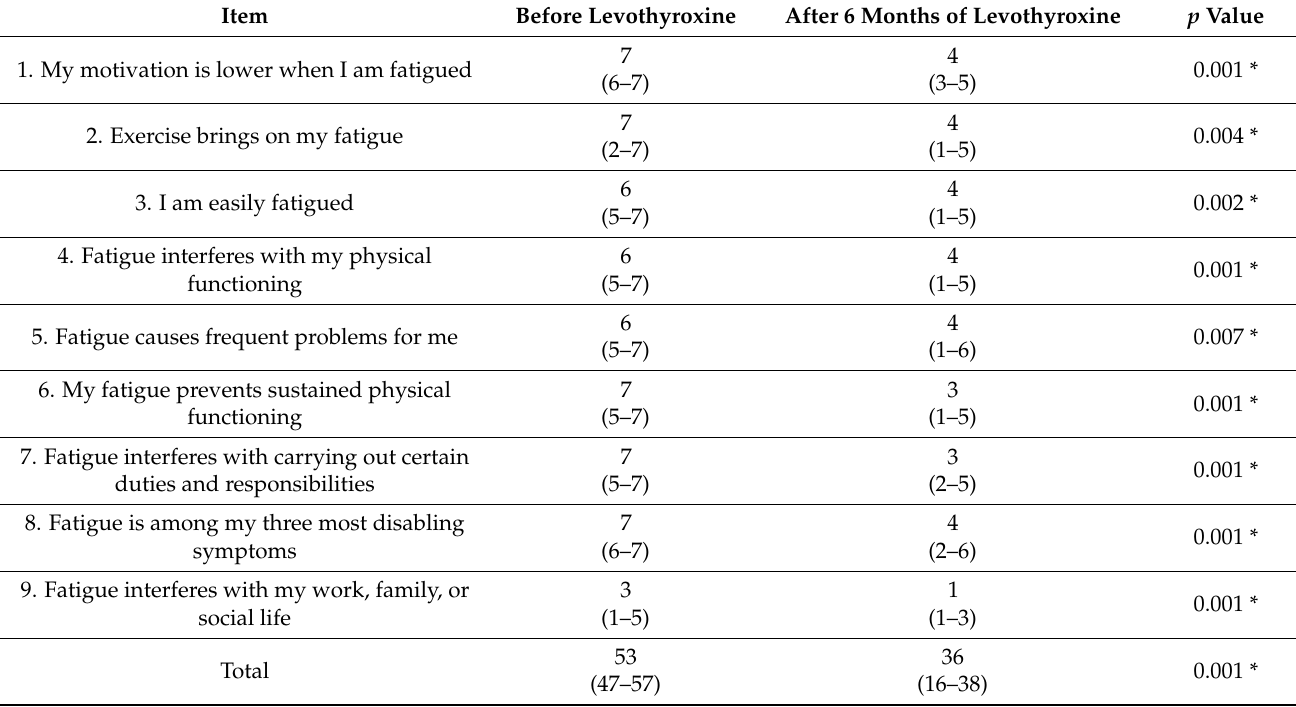
Table 2. Fatigue severity scale before and after 6 months of levothyroxine replacement therapy.